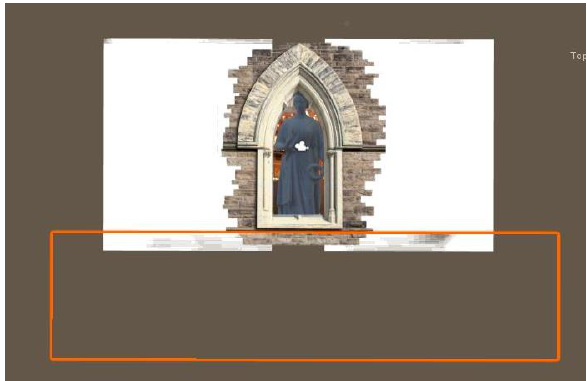
Figure 6. Unity scene with occlusion